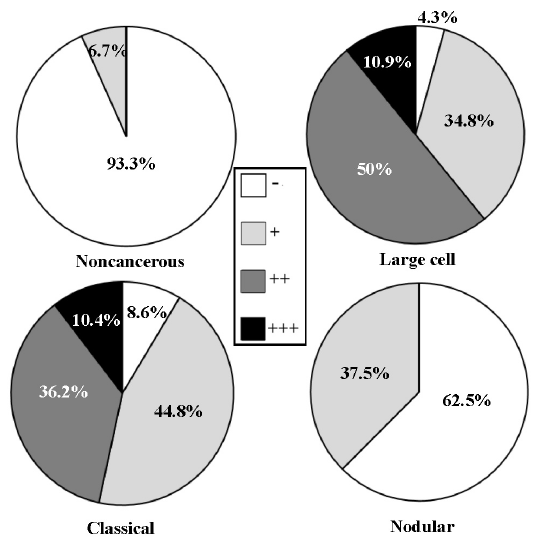
Figure 1. Incidences of p-STAT3 nuclear translocation in noncancerous brain tissues and the three histological subtypes of medulloblastomas.